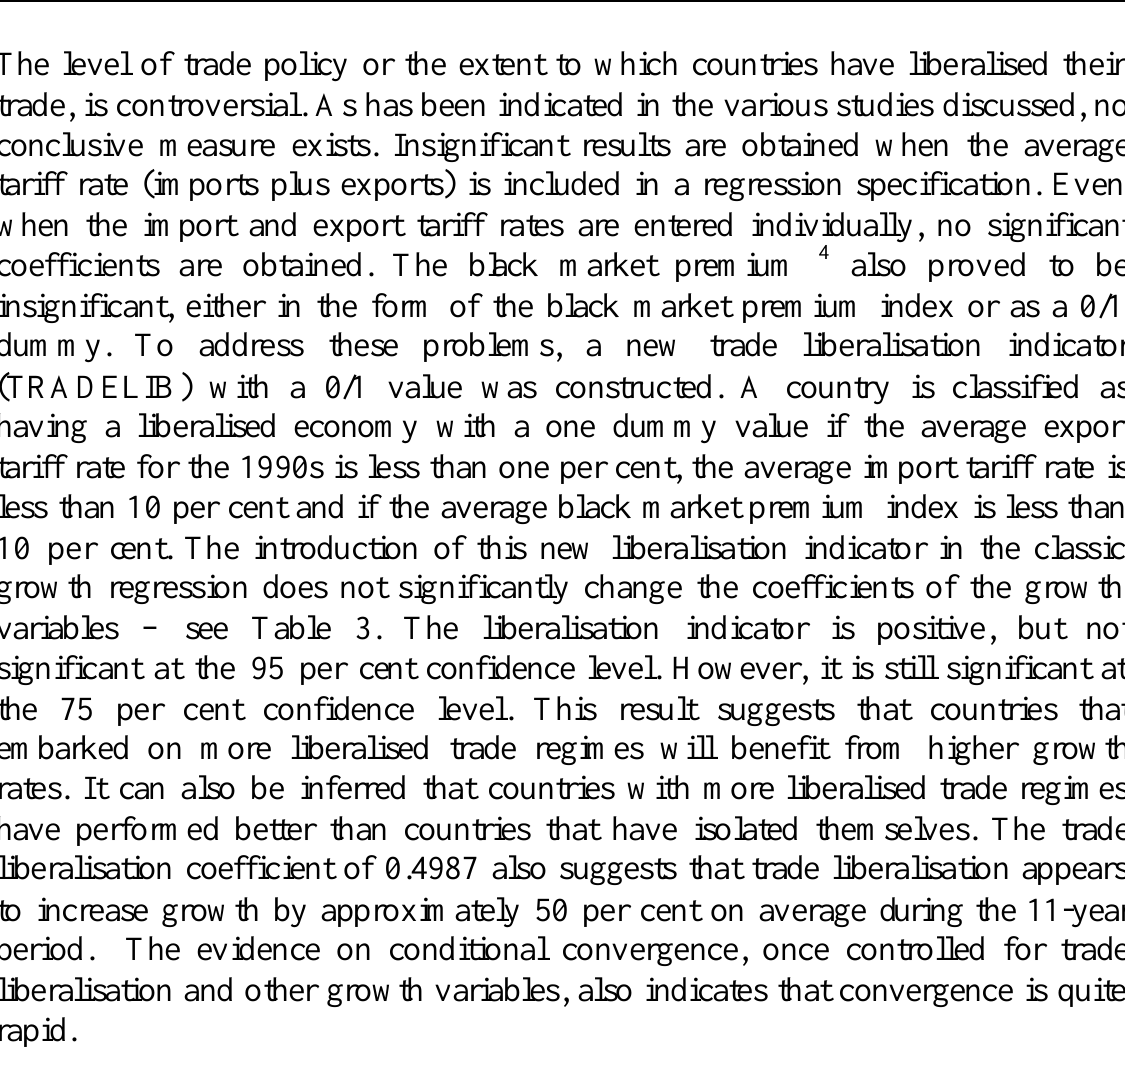
Trade liberalisation and growth